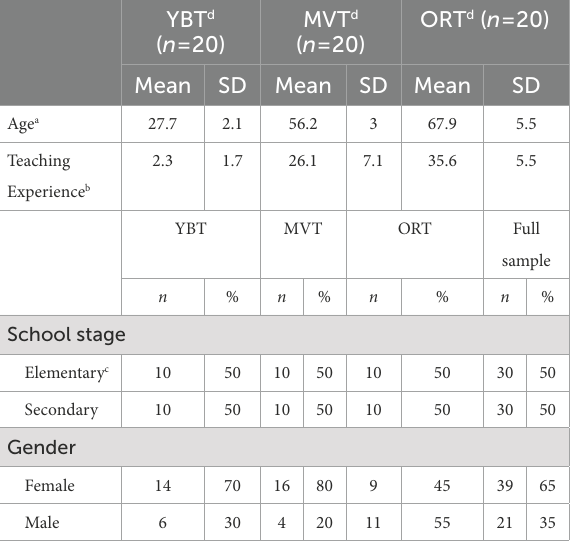
TABLE 1 Characteristics of